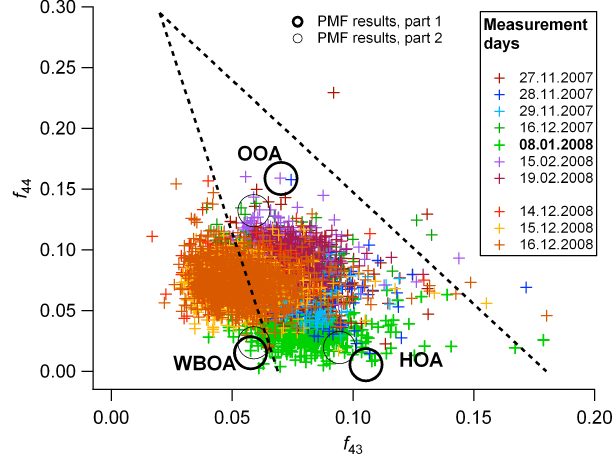
Figure 5: Fractions of organic mass fragments 44 ( f 44 ) and 43 ( f 43 ) in the Ng triangle (Ng et al., 2010), 2 measured. Black circles show the fractions for the resulting spectra from PMF. The measurement day of 3 Fig. 5. Fractions of organic mass fragments 44 ( f 44 ) and 43 ( f 43 ) in 08 January 2008 (light green dots) with a low secondary contribution (Fig. 4) shows a lower degree of 4 the Ng triangle (Ng et al., 2010), measured. Black circles show the oxygenation than the other data. 5 fractions for the resulting spectra from PMF. The measurement day of 8 January 2008 (light green dots) with a low secondary contri- bution (Fig. 4) shows a lower degree of oxygenation than the other